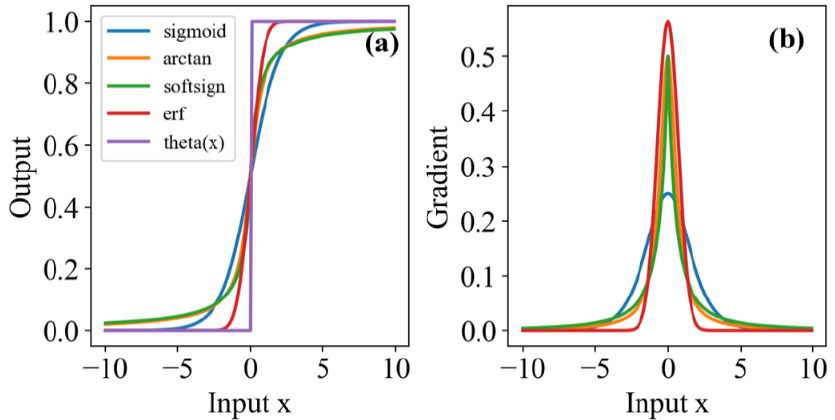
Figure 4. ( a ) Normalized surrogate gradient functions and ( b ) their corresponding gradients.